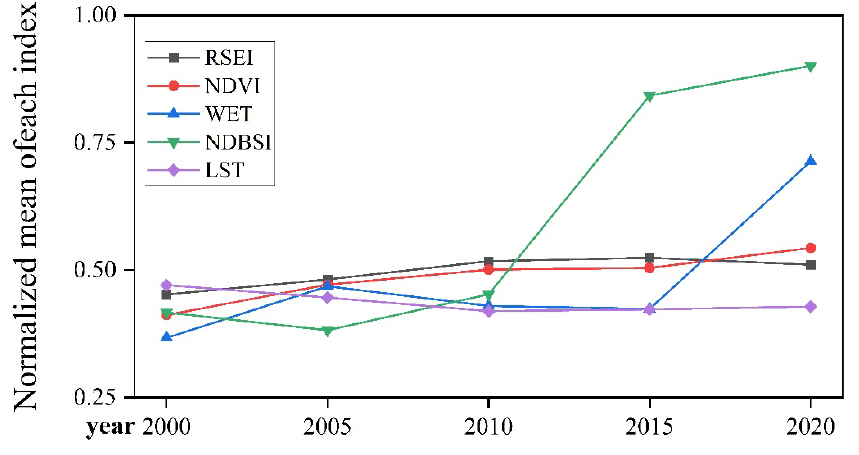
Figure 5. Time variation of each index and RSEI mean.